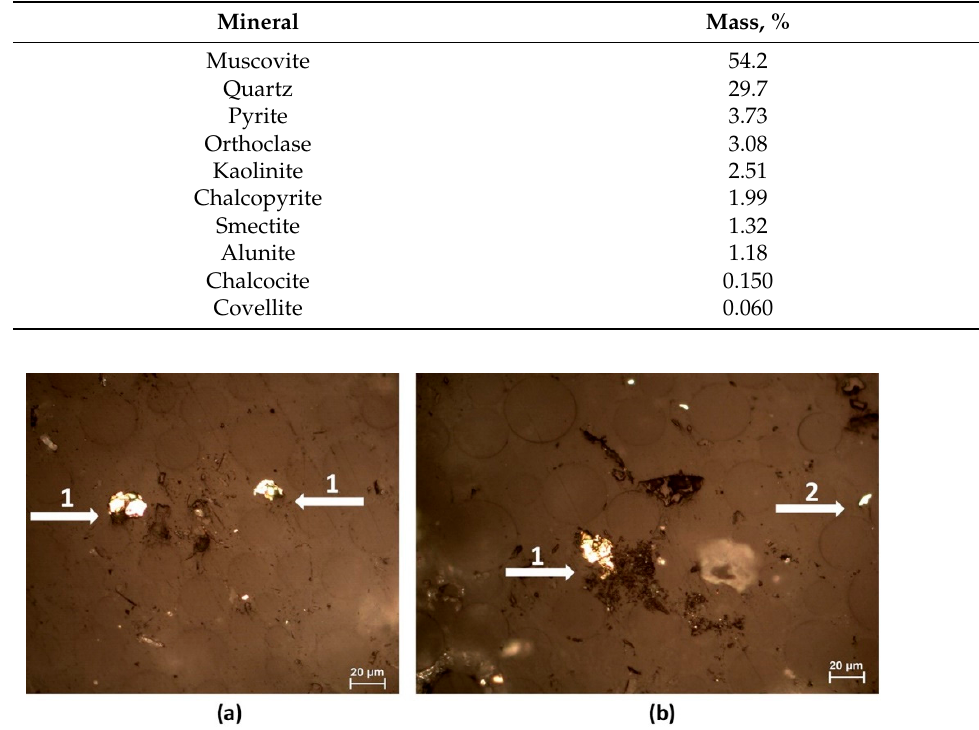
Figure 3. Reflected optical microscope images of the initial sample ( a , b ). Chalcopyrite identified in ( a ) as (1) and pyrite ( b ) as 2.